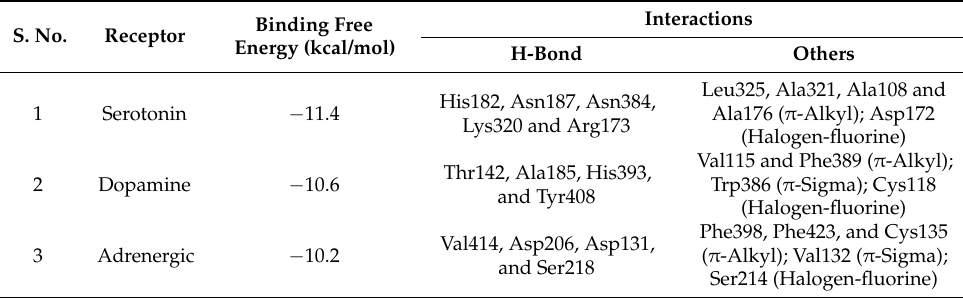
Table 3. Docking scores of the CTcS complex and its interactions with receptors.